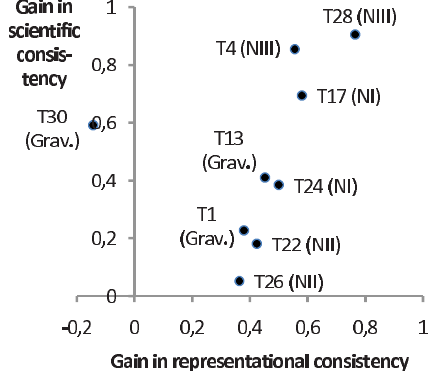
FIG. 5. (cid:1) Color (cid:2) Average normalized gains in representational and scientific consistency